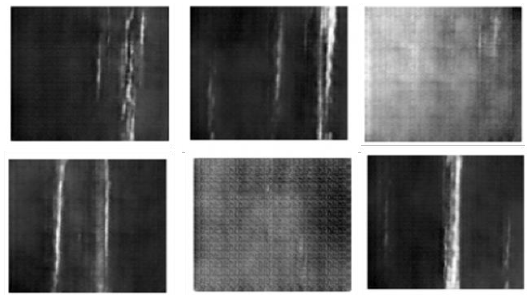
Figure 2. Examples of NEU Synthetic images generated by